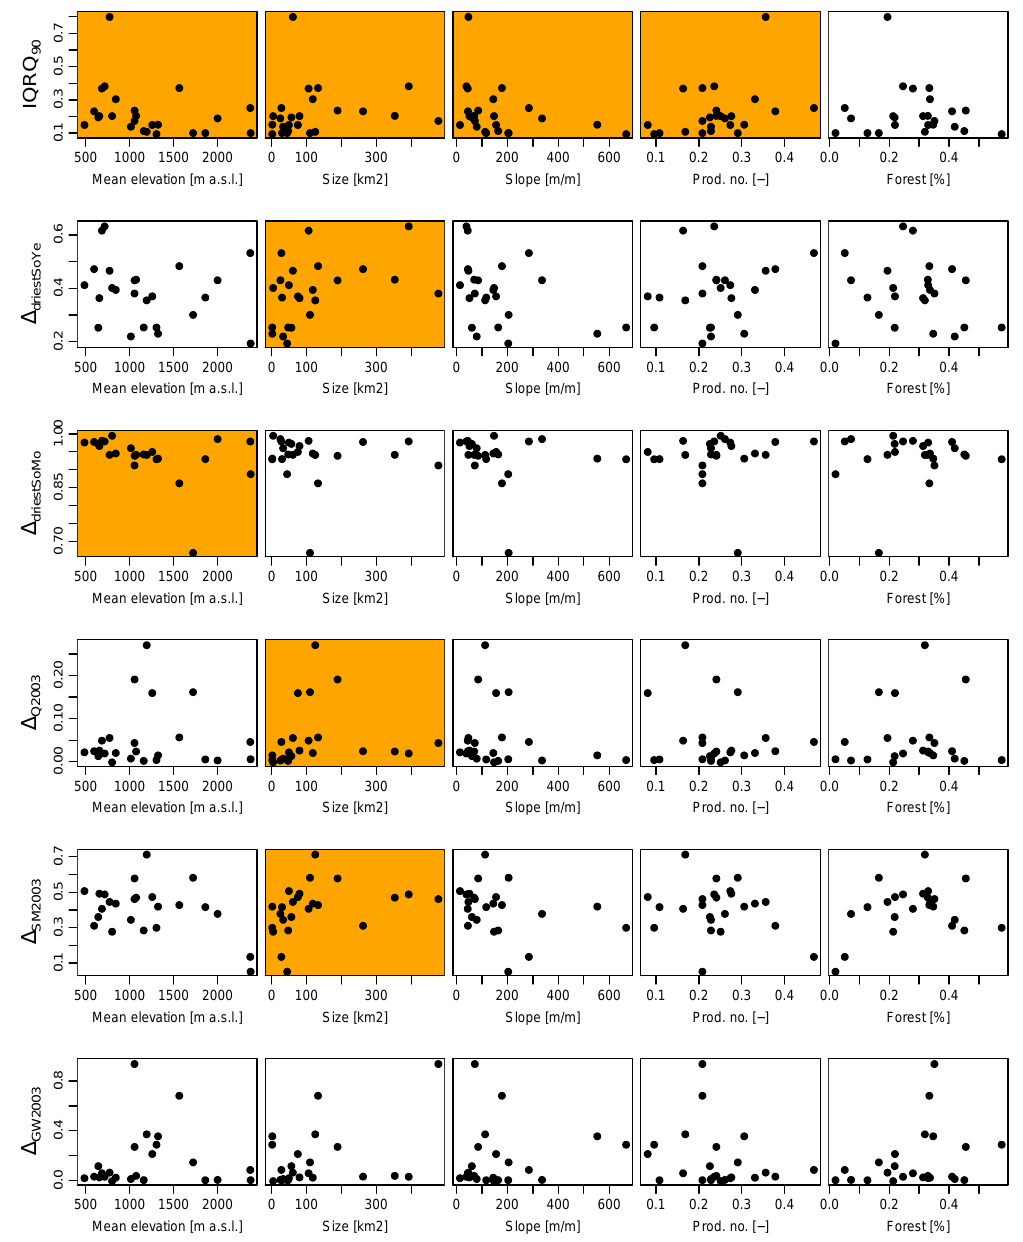
Figure 7. Indicators to drought sensitivity: days above the threshold Q 90 , (cid:49)Q Driest SoYe , (cid:49)Q Driest SoMo , and changes of summer 2003 with drier initial conditions (cid:49)Q 2003 , (cid:49) SM 2003 and (cid:49) GW 2003 compared to simple catchment characteristics. The orange background indicates a significant correlation (5% level) between the respective indicator and catchment characteristic. Prod. no. is the hydrogeological productivity number as introduced in Sect.